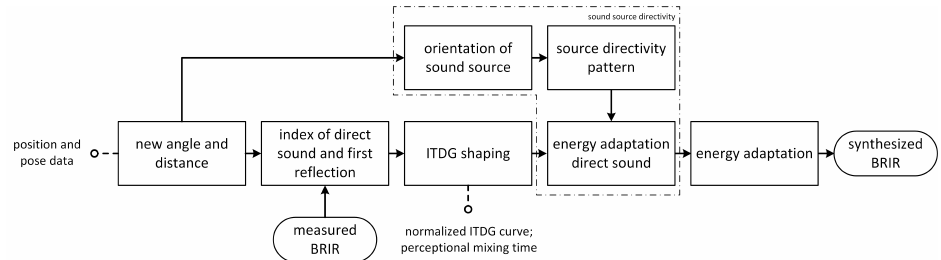
Figure 8. Block diagram of the synthesis chain to include directivity patterns in the ITDG- shaping